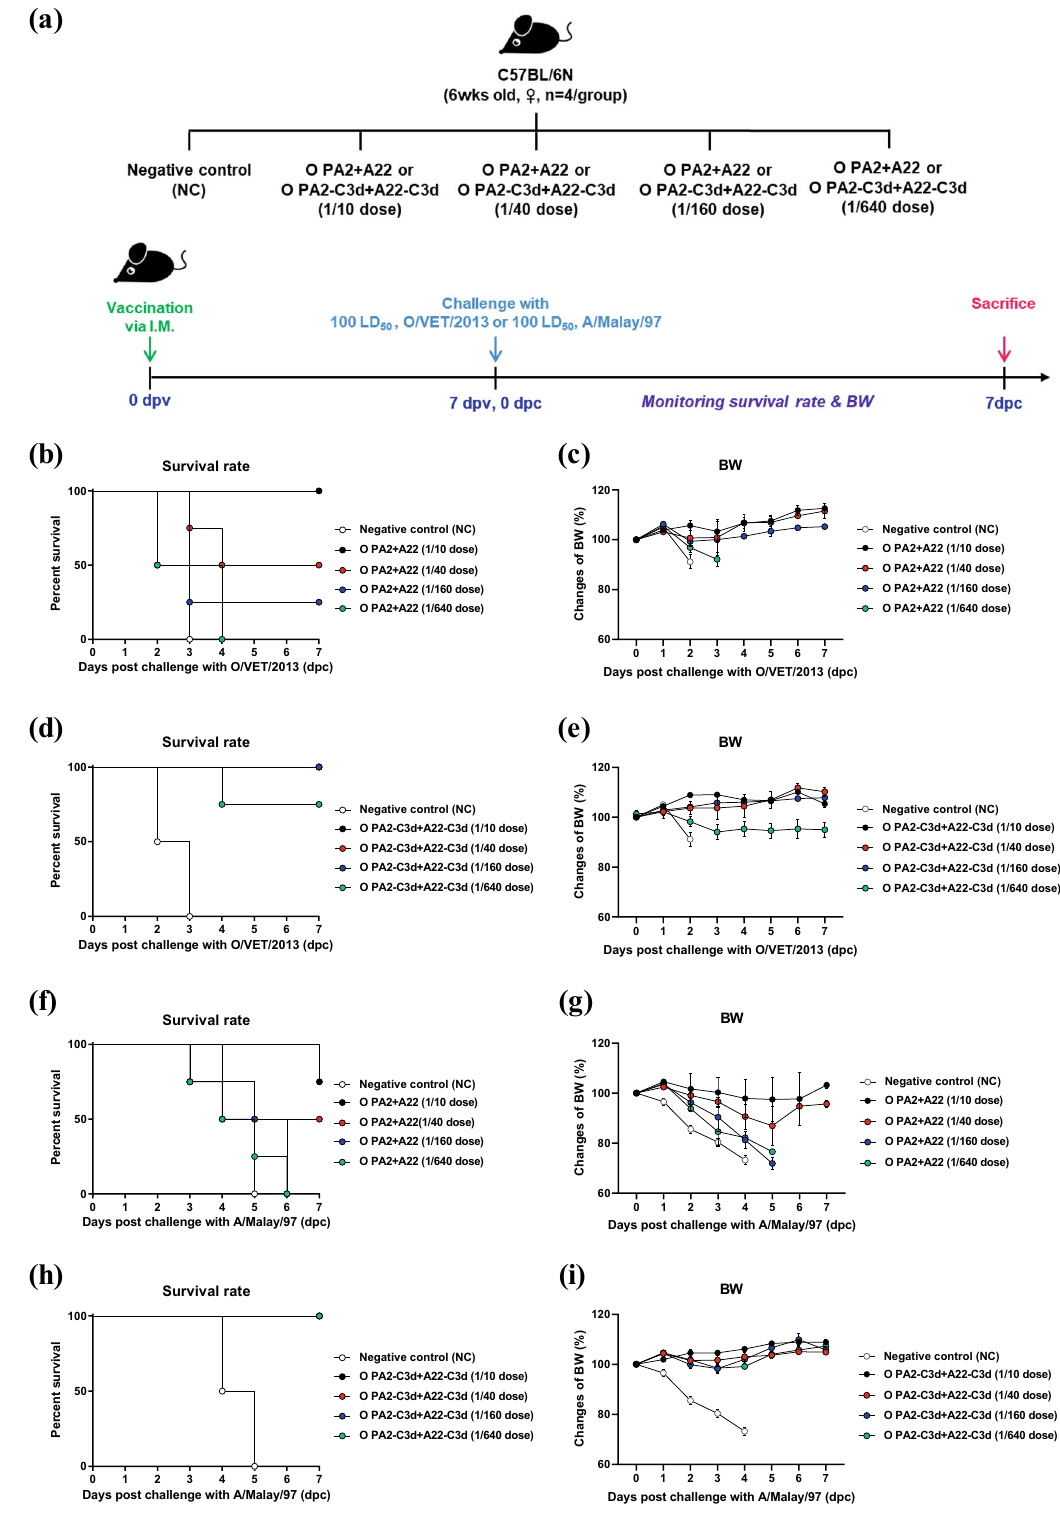
Fig. 3 Vaccine ef fi cacy and protective effects of a bivalent test vaccine containing the O PA2-C3d and A22-C3d antigens. C57BL/6 mice ( n = 4/group) were administered the test vaccine at 1/10, 1/40, 1/160, 1/640 doses of O PA2 + A22 antigen or O PA2-C3d + A22-C3d antigen for cattle or pig use, ISA 206 (oil-based emulsion, 50%, w/w), 10% Al(OH) 3 , and 15 µg Quil-A. A negative control (NC) group was injected with the same volume of PBS. The test vaccines were injected intramuscularly into mice that were later challenged with FMDV type O (100 LD 50 O/ VET/2013) or FMDV type A (100 LD 50 A/Malay/97) at 7 dpv. The survival rates and body weights were monitored for 7 dpc. ( a – i ) Experimental strategy ( a ); survival rates post-challenge with O/VET/2013 ( b , d ) or A/Malay/97 ( f , h ); changes in body weight post-challenge with O/VET/2013 ( c , e ) or A/Malay/97 ( g , i ). The data represent the mean ± SEM of triplicate measurements ( n =